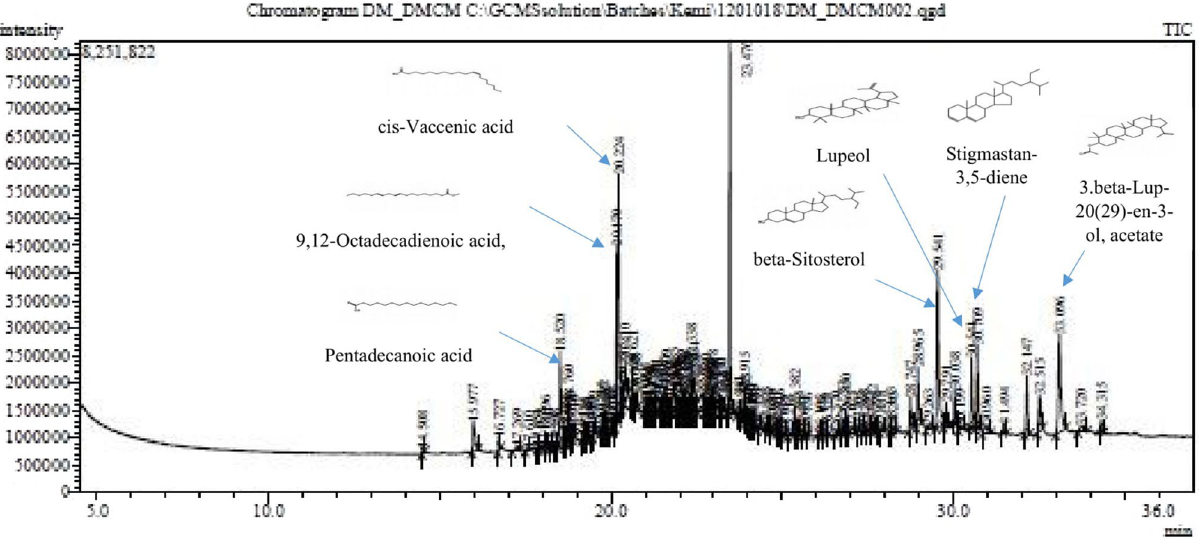
Figure 5. The GC–MS chromatogram of dichloromethane fraction of D. mespiliformis.